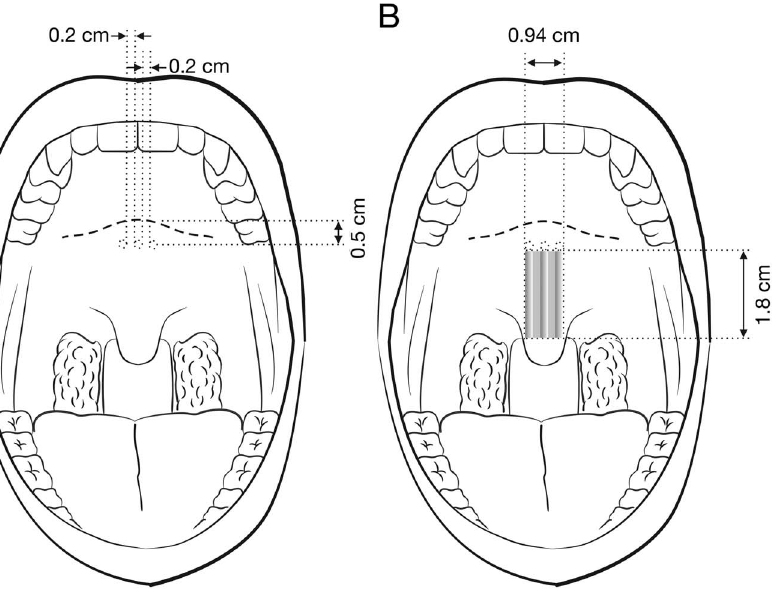
Figure 3. Palatal implant surgery. (A) Preoperative frontal view demonstrating the 3 operative sites of the soft palate (0.5 cm below the hard palate-soft palate junction; 0.2 cm between the midline and para-midline sites). (B) Postoperative frontal view showing the stiffened zone (grey zone) by the implant (1.8 cm 6 0.94 cm).